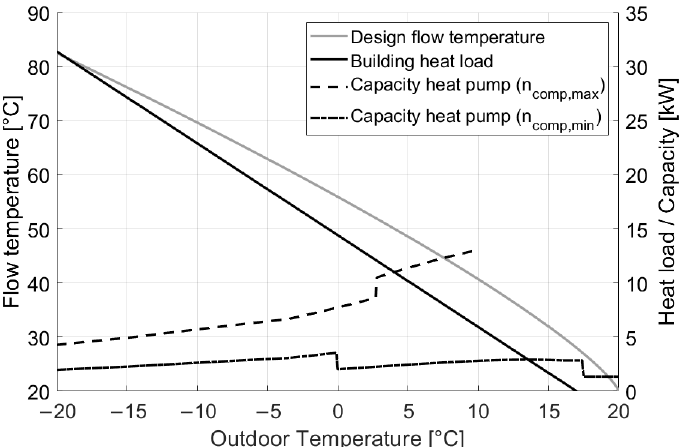
Figure 4. WCC flow temperature and heat load of the building with the thermal capacity of the heat pump with maximum and minimum compressor